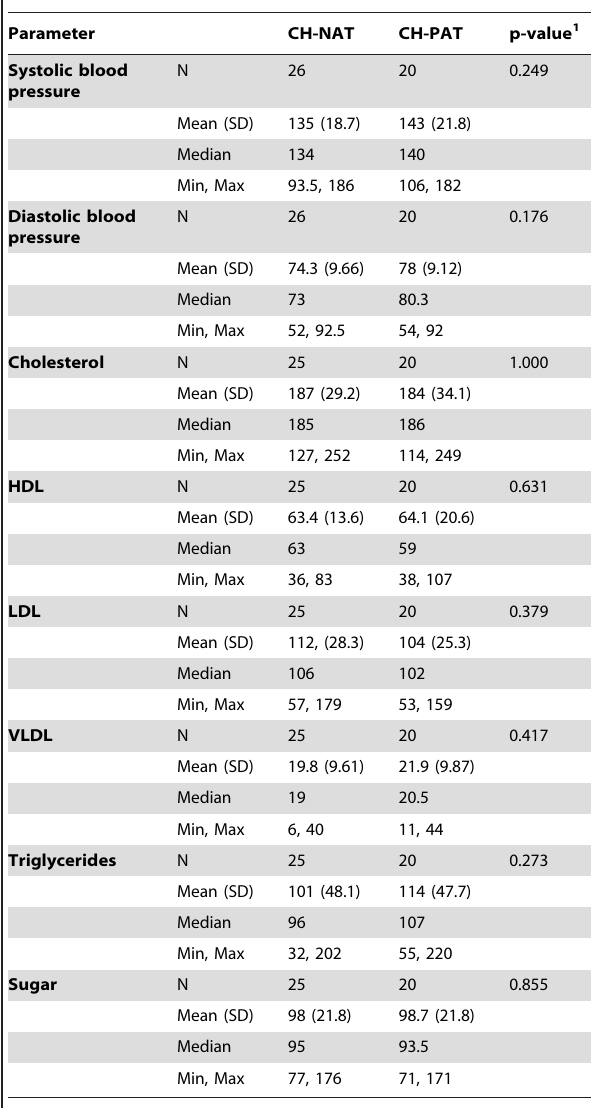
Table 6. Cerebrovascular risk factors.